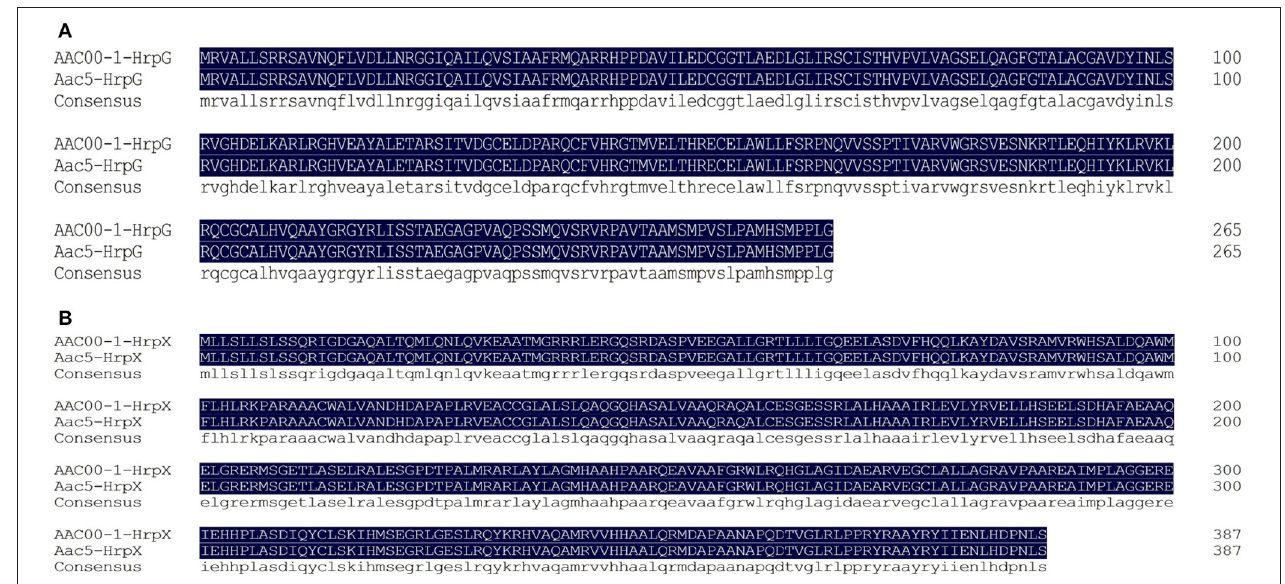
FIGURE 1 | Multiple alignments of the deduced amino acid sequences of HrpG and HrpX proteins. (A) HrpG with AAC00-1 and Aac5; (B) HrpX with AAC00-1 and